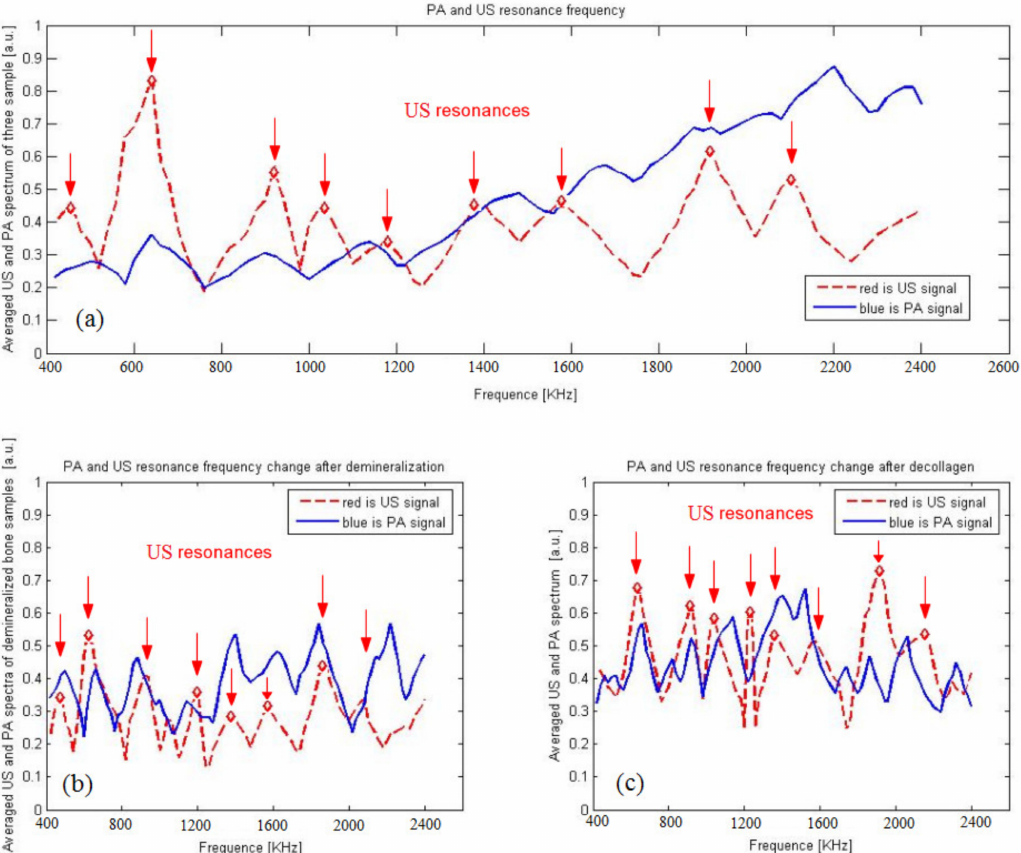
Figure 7. Normalized spectra for US and PA signals vs. source frequency. ( a ) PA and US resonance frequency. ( b ) PA and US resonance frequency change after deminieralization. ( c ) PA and US resonance frequency change after